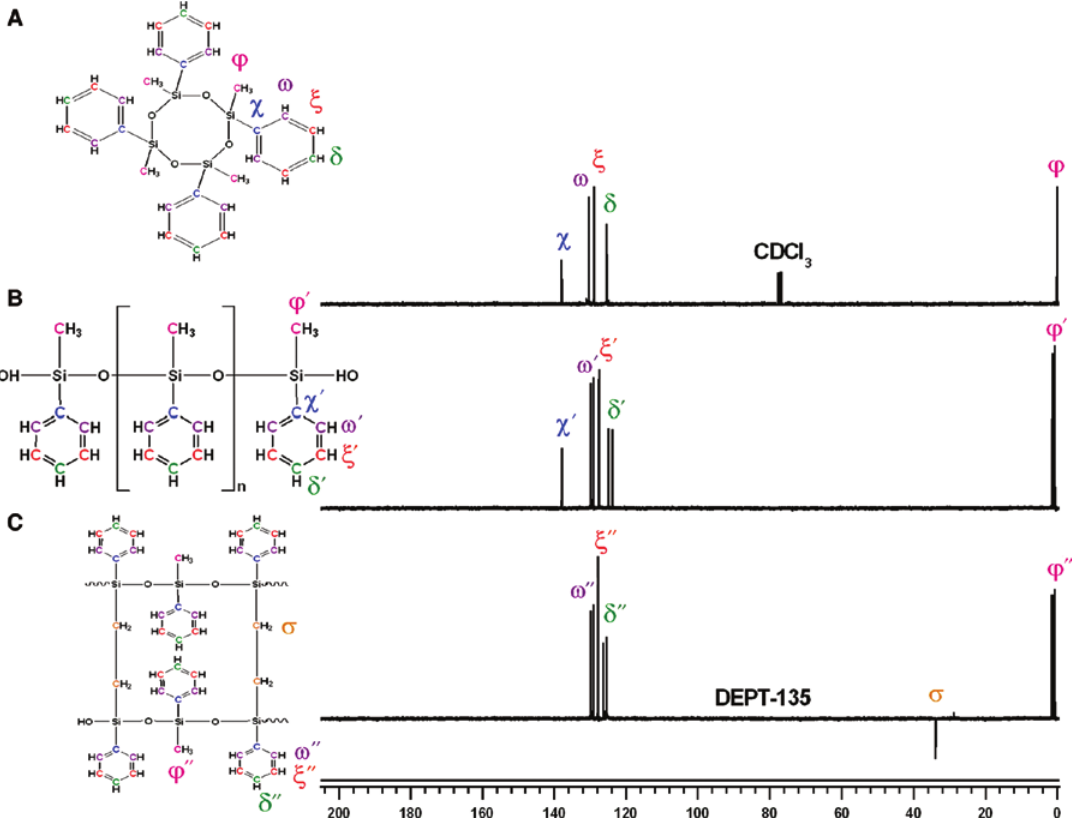
Figure 4: 13 C nuclear magnetic resonance (NMR) spectra of (A) tetraphenyltetramethylcyclotetrasiloxane (D 4Ph,Me ), (B) polymer obtained after 150 min and (C) polymer obtained after 180 min at a temperature of 60 °